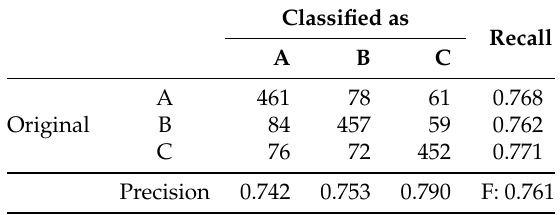
Table 10. Confusion Matrix of Linkage Line Visibility Classification with Selected 14 Features.